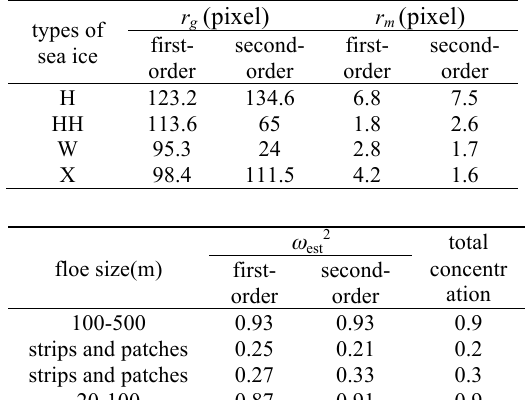
Fig. 11 Result of the estimation of the first-order and second-order variograms from polygons (Fig.